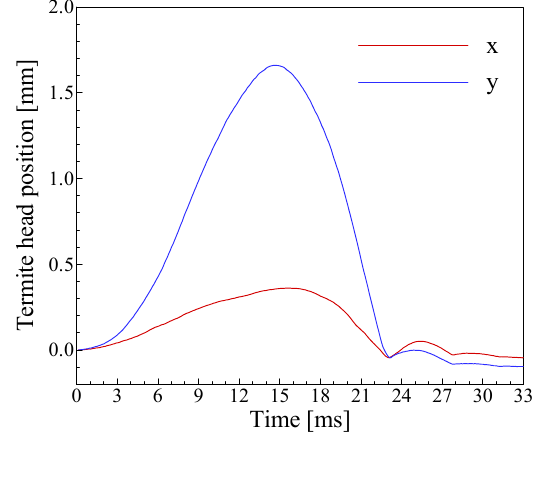
Figure 10. Time histories of the termite head position in a 33-ms head-banging